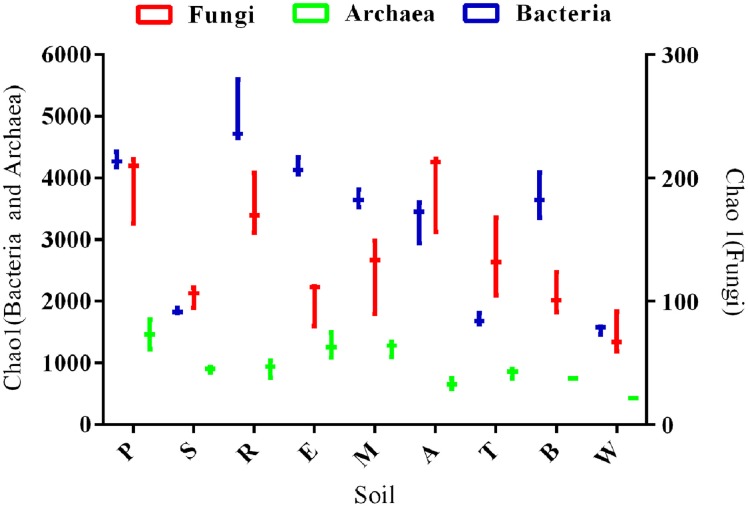
Box and whisker plot of bacterial, fungal and archaeal species richness estimated by Chao1 metric. All samples were rarified to a common read level. Letters indicate soil names, and are abbreviated as: A, Arena; B, Brasso; E, Ecclesville; M, Maracas; P, Piarco; R, River Estate; S, St. Augustine; T, Talparo and W, Princes Town.